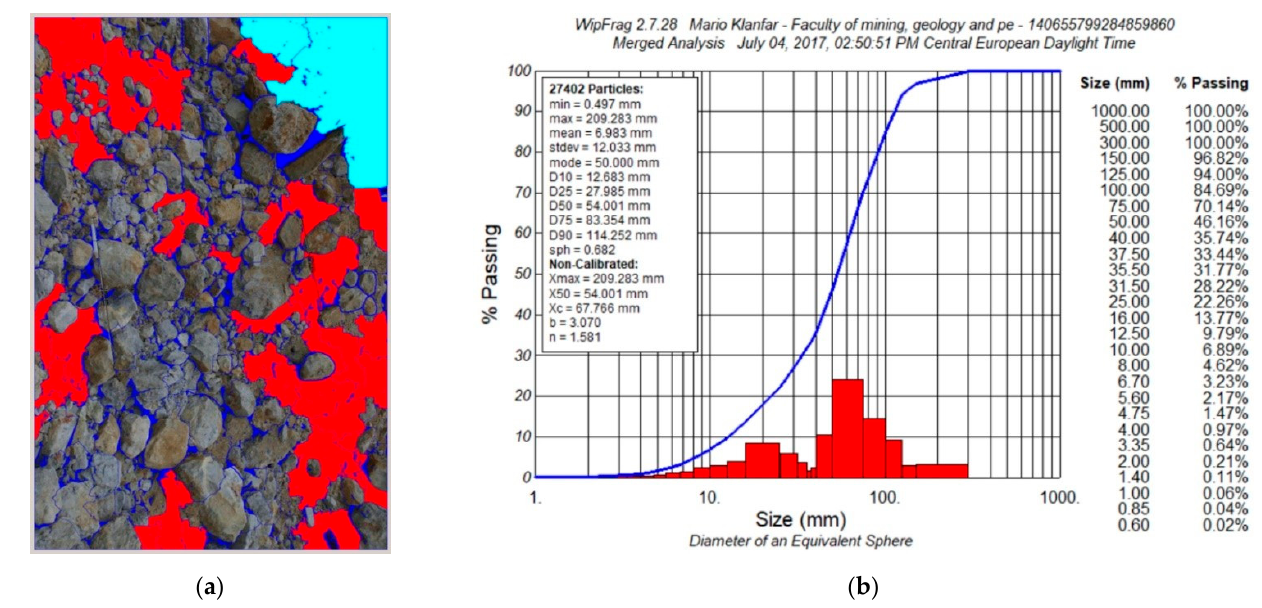
Figure 3. Determination of rock size distribution parameters: ( a ) digital image; ( b ) rock particle size diagram. Table 1. Results of field measurements and granulometric analysis. Table 1. Results of field measurements and granulometric